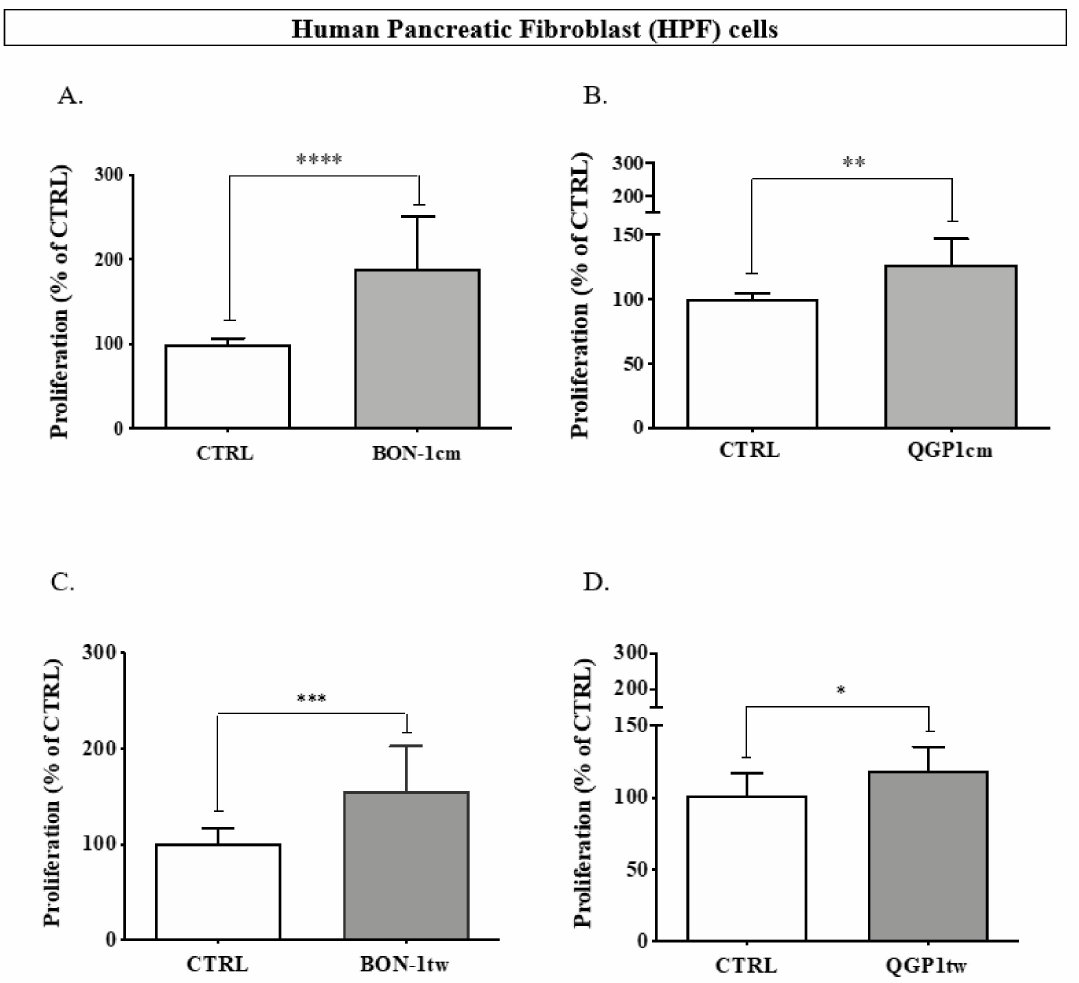
Figure 6. Impact of BON-1cm ( A ) and QGP-1cm ( B ) on the proliferation of HPF cells. Similar exper- iments were conducted with BON-1 ( C ) and QGP-1 ( D ) in transwells. **** p < 0.0001; *** p < 0.001; ** p < 0.01; * p <